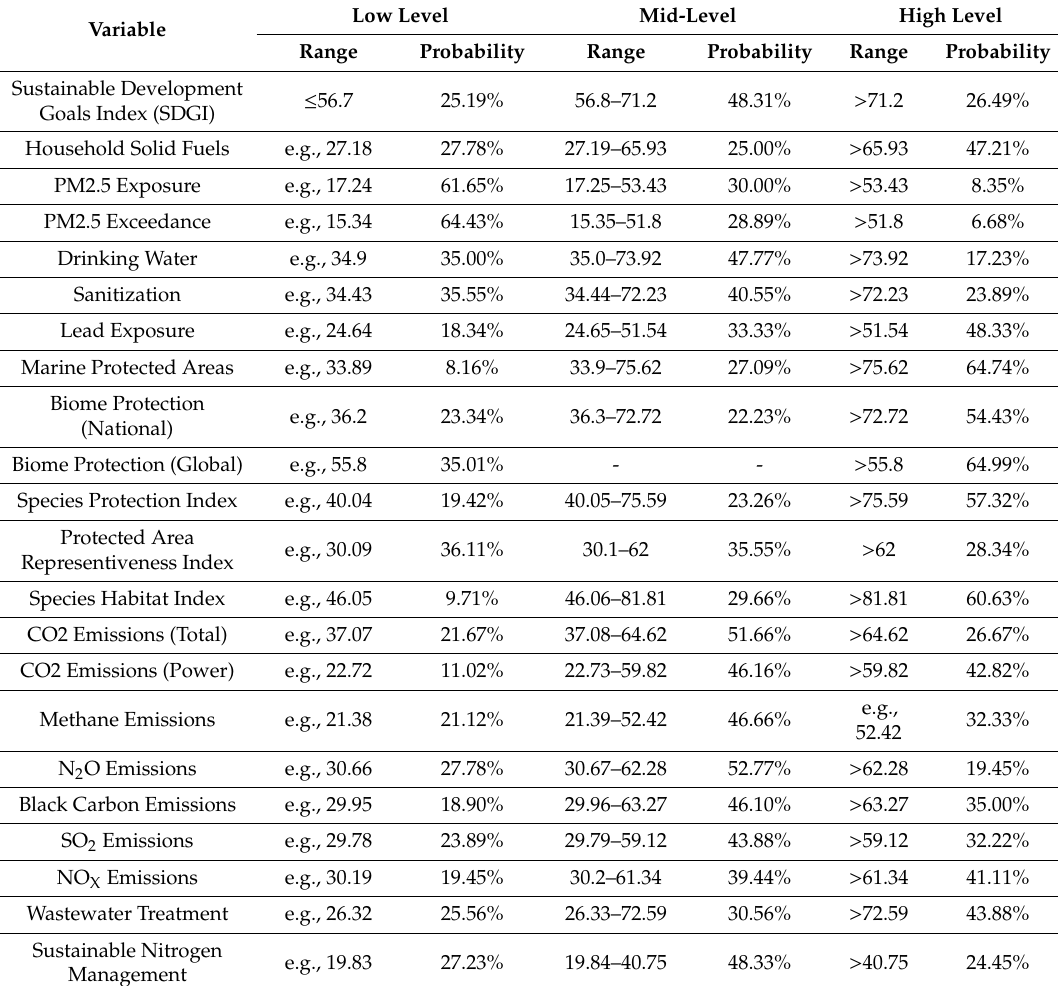
Table 2. Results of descriptive analysis of the 2018 EPI